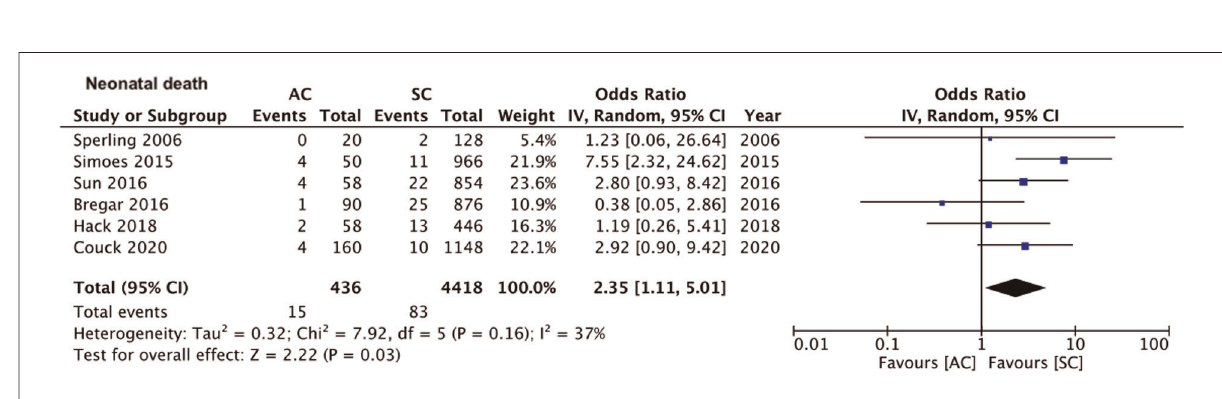
FIGURE 8 Meta-analysis of neonatal death between assisted and spontaneously conceived monochorionic twin